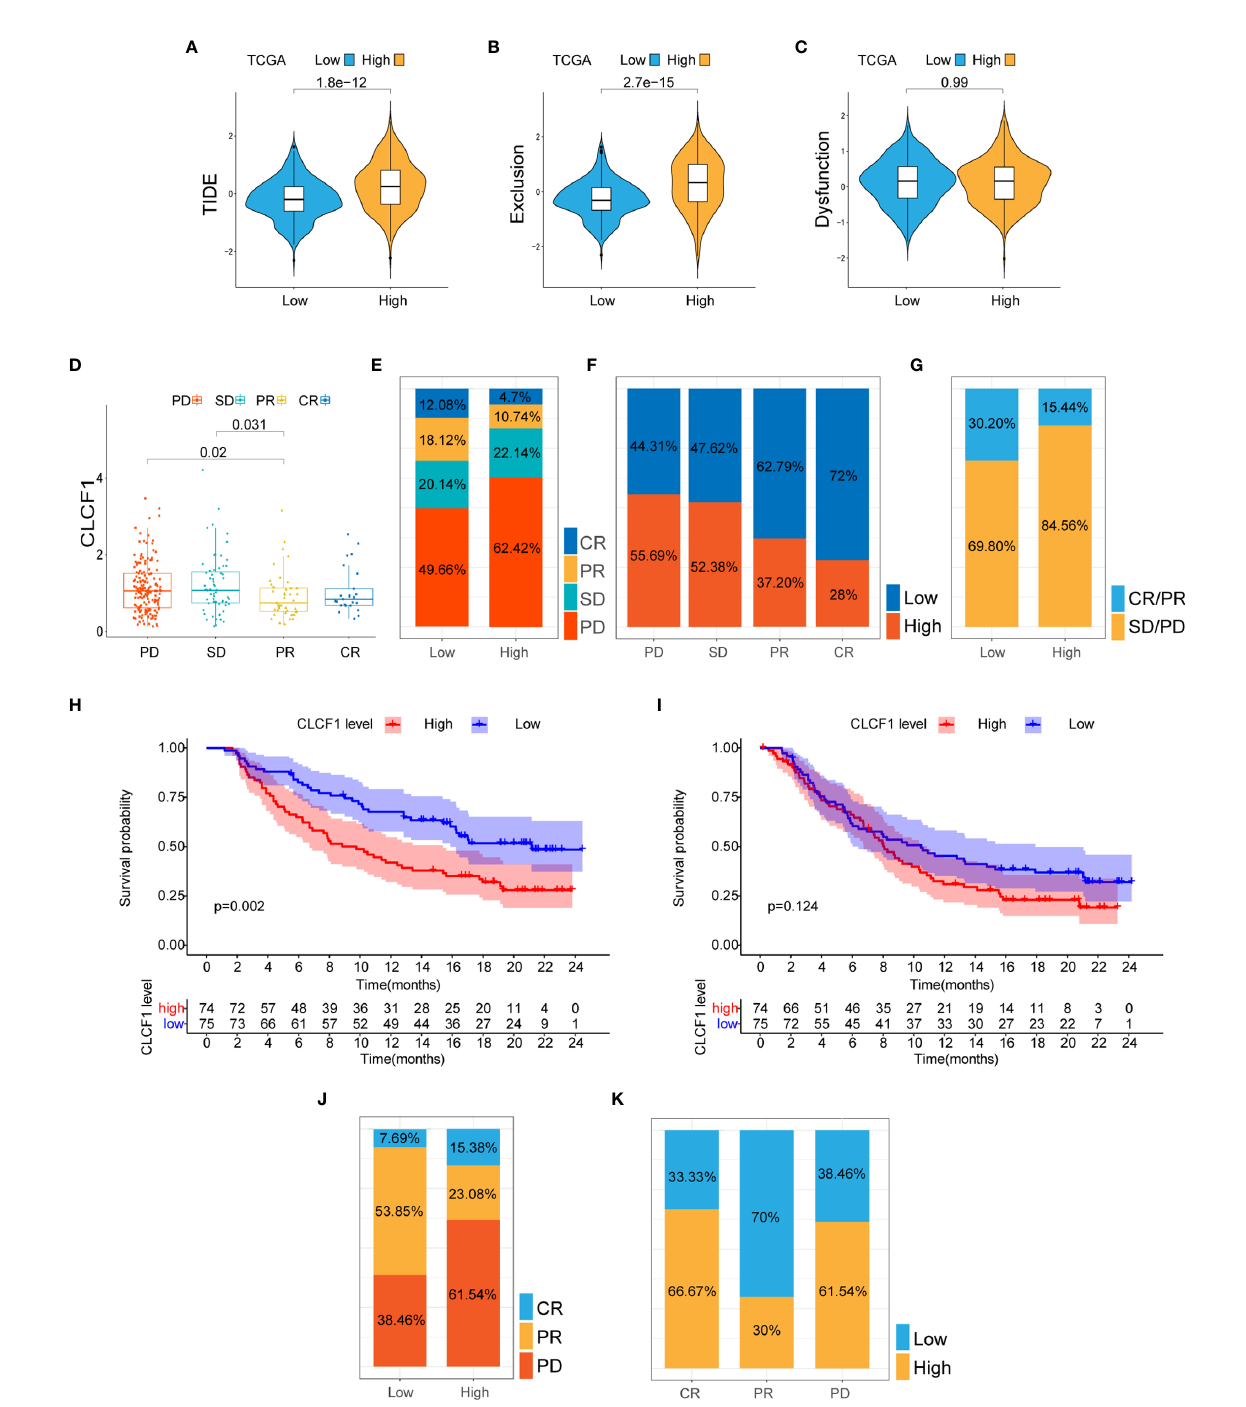
FIGURE 7 | (A – C) The TIDE, T cell exclusion, and dysfunction score in low and high CLCF1 subgroups in TCGA; (D) Expression difference of CLCF1 in different anti-PD-L1 clinical response groups in the IMvigor210 cohort; The proportions of various immunotherapy response types in the high and low CLCF1 expression subgroups in the IMvigor210 cohort (E) and the GSE 78220 cohort (J) ; The proportion of high and low CLCF1 expression correlated with clinical immunotherapeutic response subgroups in the IMvigor210 (F) and GSE 78220 (K) cohorts; (G) The proportions of clinical responses to anti-PD-L1 immunotherapy in the high and low CLCF1 groups in the IMvigor210 cohort; Kaplan-Meier survival plot of CLCF1 in the high PD-L1 group (H) and low PD-L1 group (I) in the IMvigor210